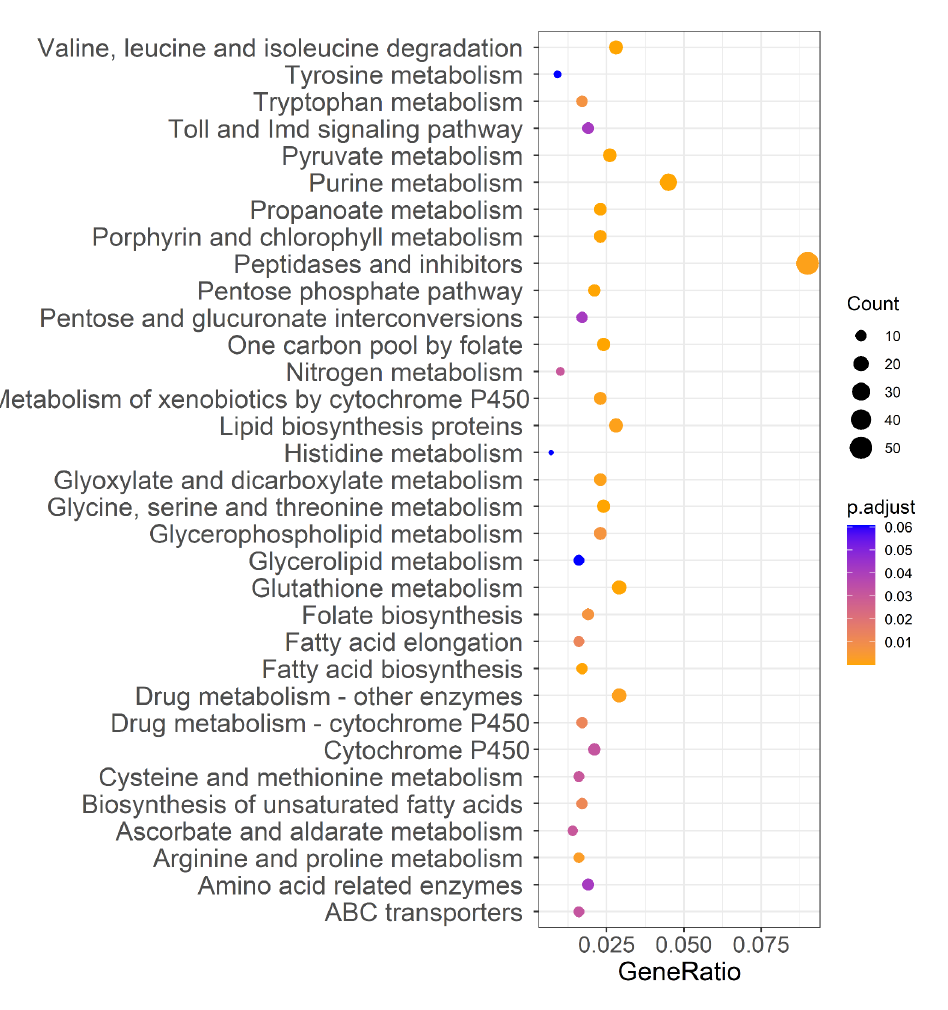
Figure 5. KEGG pathway annotation classification of DEGs between strains. The ordinate left is the KEGG pathway, and the abscissa is the ratio of genes enriched in the pathway. The size of the round spot represents the number of genes enriched in the pathway, and the color represents the size of P adjust value.